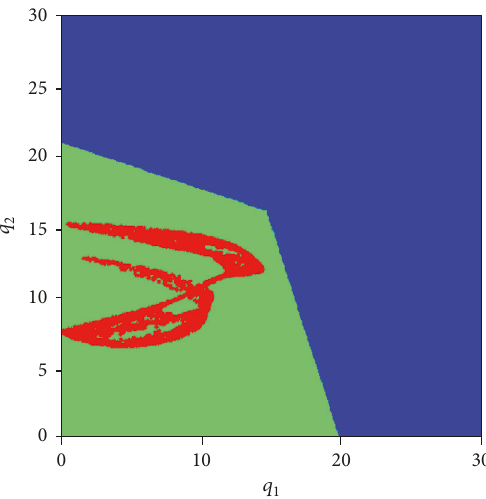
Figure 24: Basins of attraction, 𝛼 = 0.3 , 𝛽 = 0.1 , and 𝑞 3 = 10 .